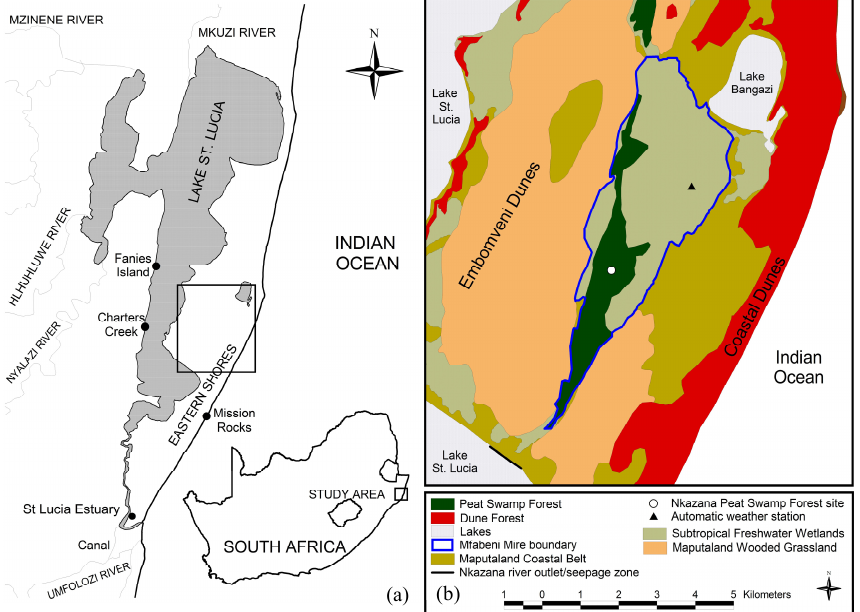
Figure 2. (a) Location of the Eastern Shores within South Africa, (b) the Nkazana Peat Swamp Forest site (where the EC and sap-flow systems were located) and the automatic weather station within the Mfabeni Mire on the Eastern Shores (data from Mucina and Rutherford,